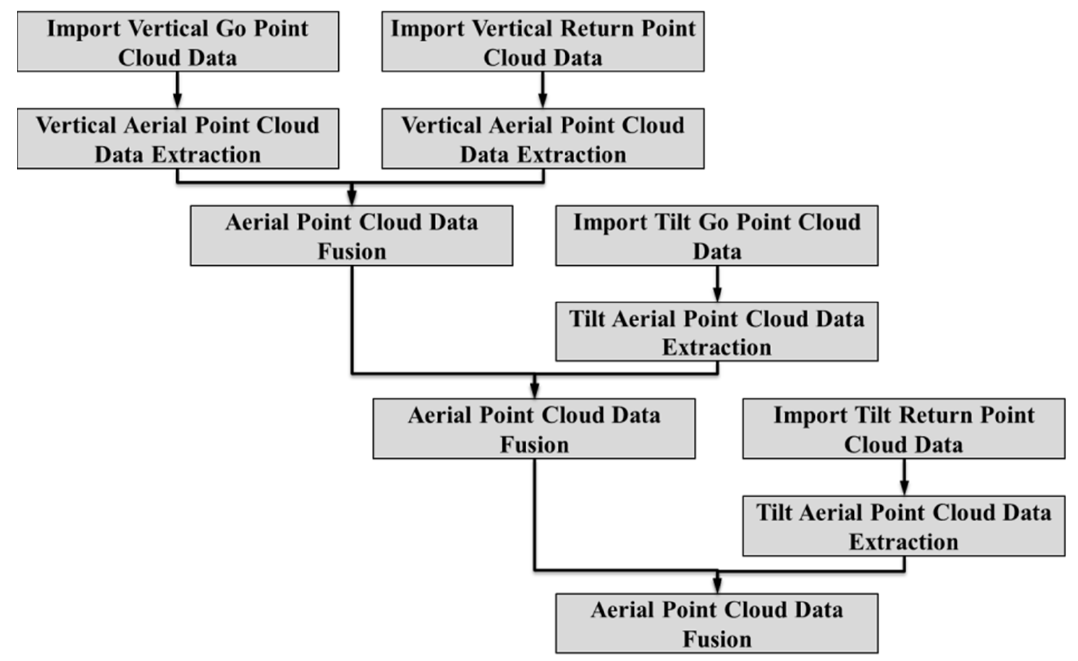
Figure 5. Overlapping process followed at each path and row. Figure 6. Overlapping process followed at each path and